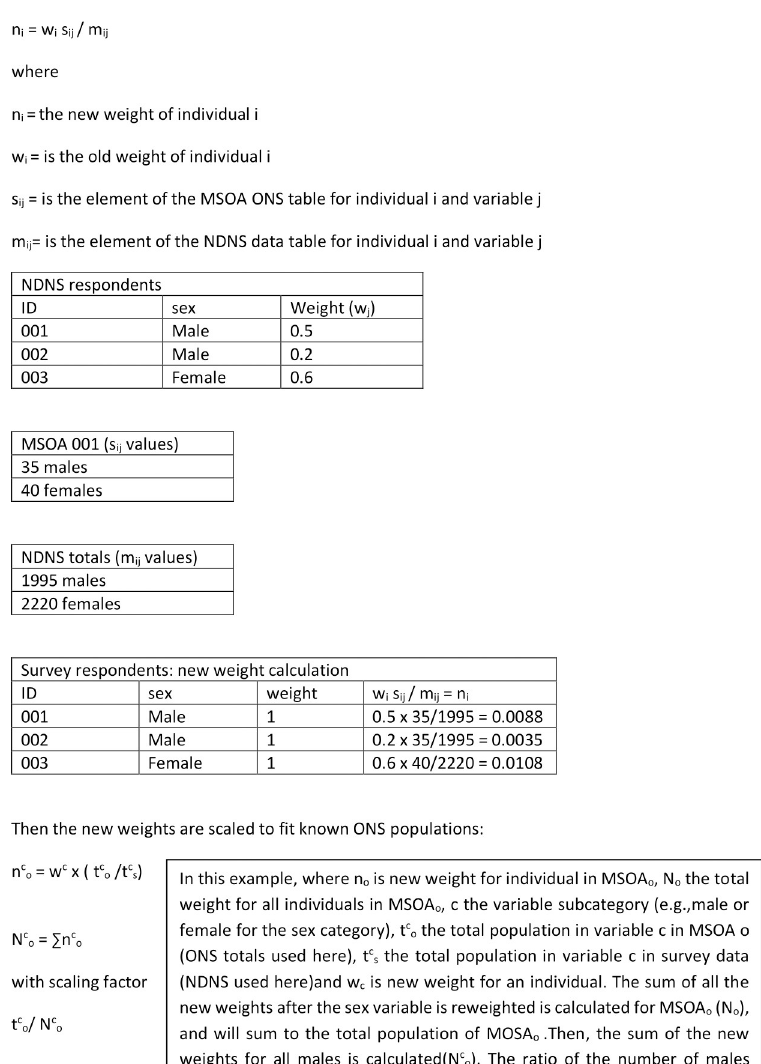
Fig 1. Worked example of IPF routine for